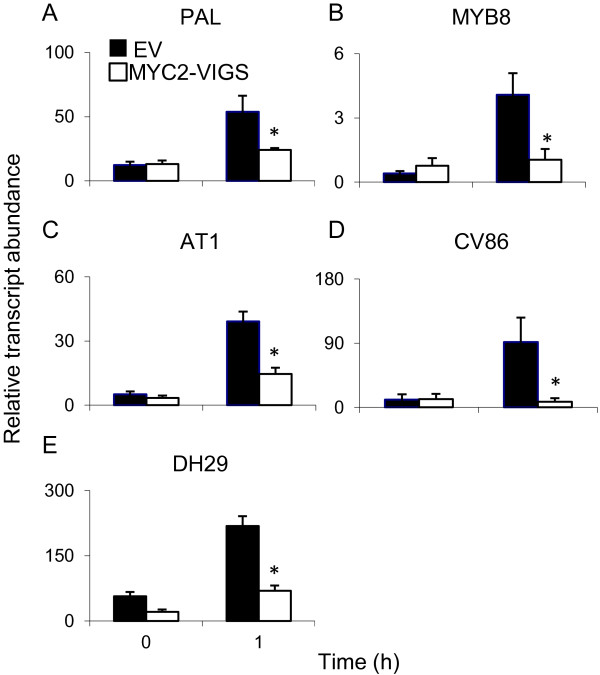
Transcript accumulation of selected genes involved in phenolamide biosynthesis in EV and MYC2-VIGS N. attenuata plants. Transcript abundance (mean ± SE; n=5) of genes involved in JA-dependent phenolamide biosynthesis was determined in WOS-induced EV and MYC2-VIGS plants. Quantification was performed by qRT-PCR using the house-keeping gene, Elongation Factor 1α (EF-1α), for normalization. One h after WOS-treatment, significant reductions (ANOVA, P < 0.05, indicated by asterisks) were observed in transcript accumulation of PAL (A), MYB8 (B), AT1 (C), CV86 (D) and DH29 (E) in MYC2-VIGS plants.